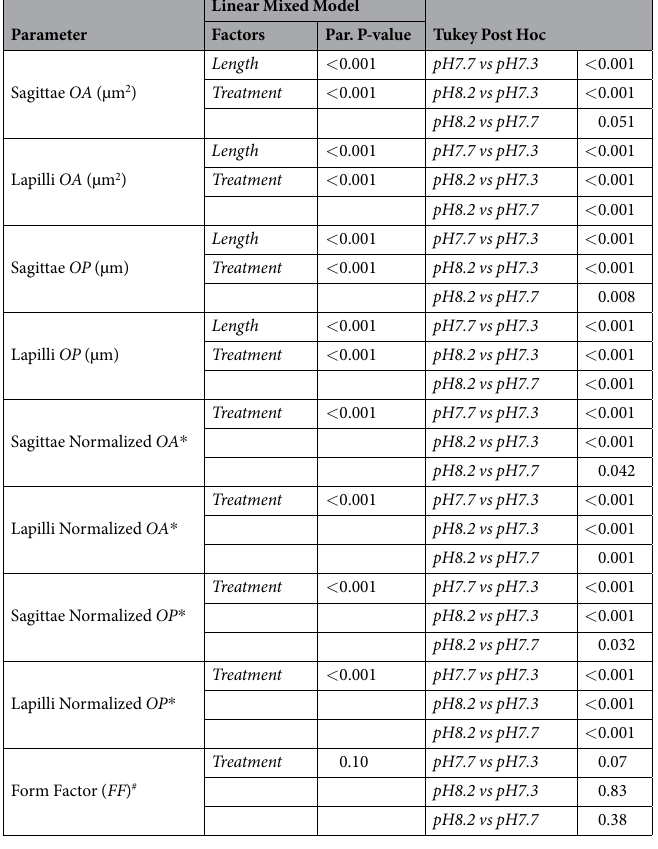
Table 2. Level of significance between treatments for the otolith parameters measured. OA = Otolith area. OP = Otolith perimeter. * Normalized values = OA or OP /animal length. # Form Factor (FF) = 4 π OA x OP − 2 , where OA is the sagittal area and OP is the